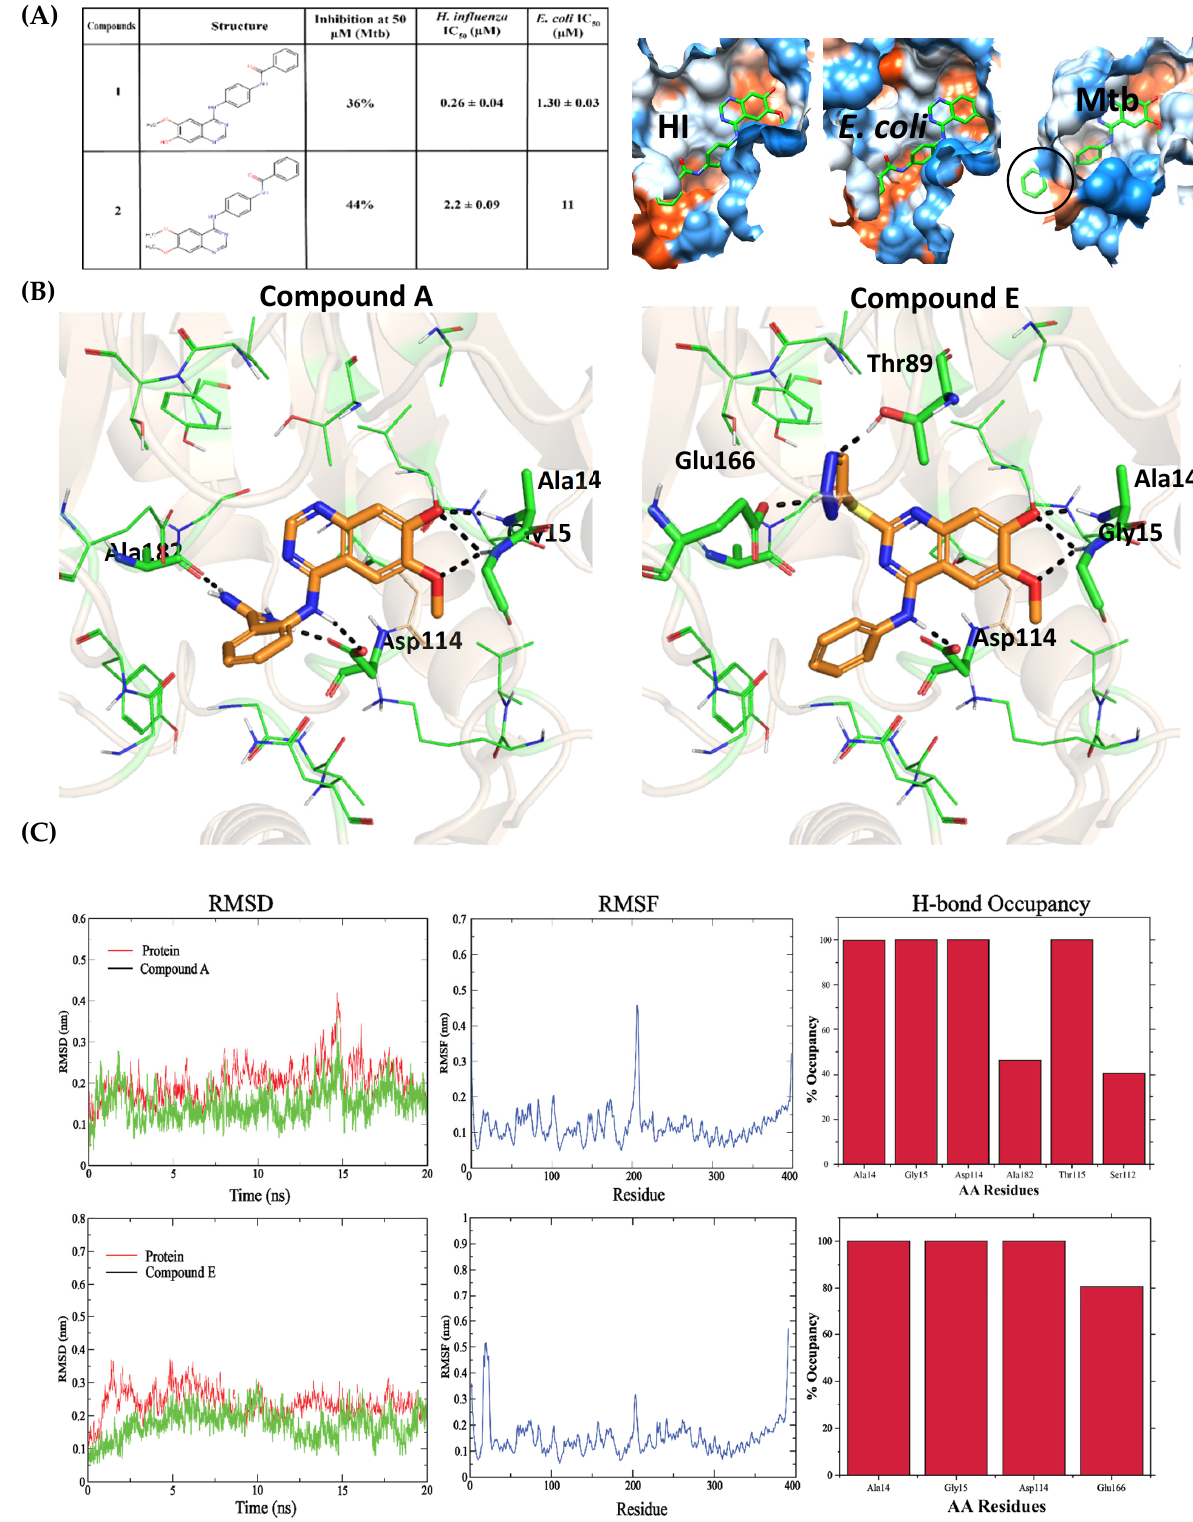
Figure 3. ( A ) The two compounds which were tested on all three organisms Mtb, HI and E. coli